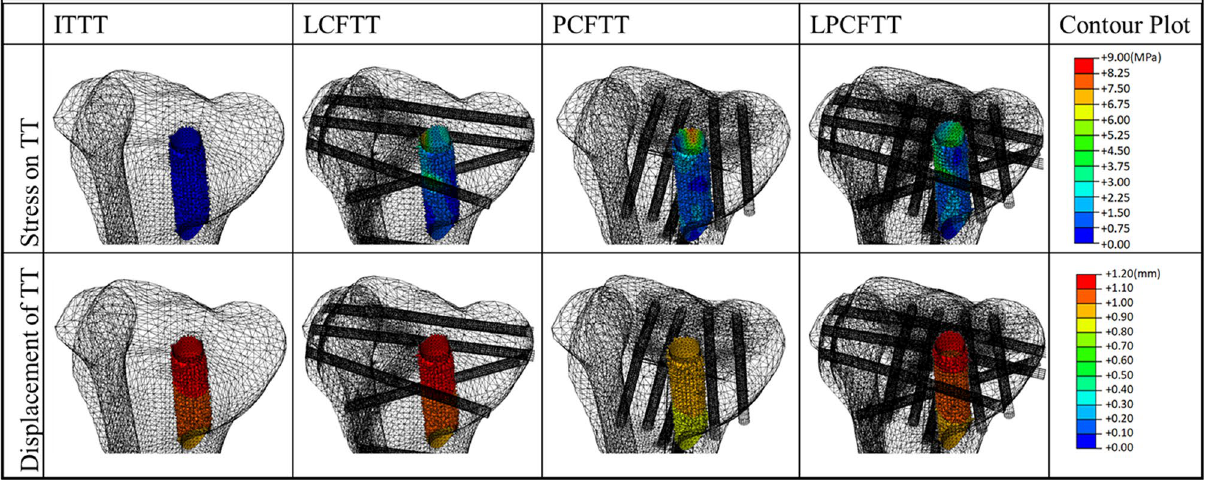
Figure 4. Corresponding plot contours of Von Mises stress and displacement of TT and deformation scale factor for each model was uniform and the value of it was one (created by Abaqus 6.14, https